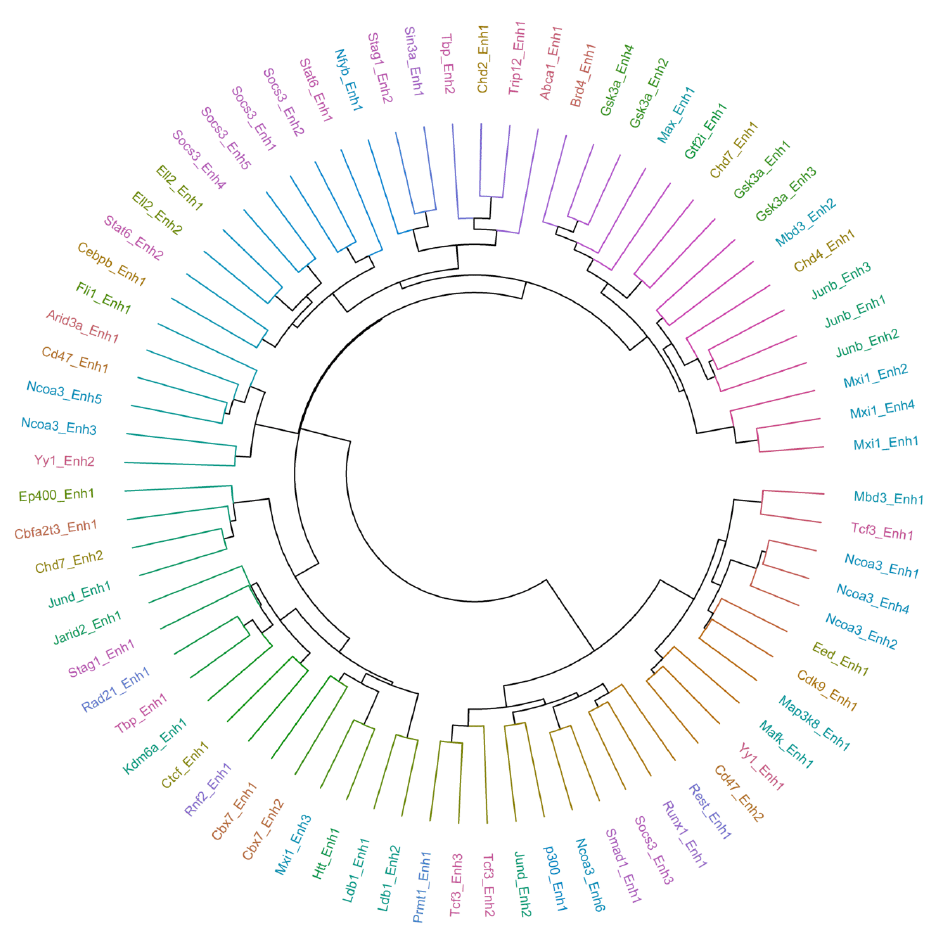
Figure 5. Hierarchical representation of similarities between transcription factor-target sets predicted using Findr-A causal inference on the FANTOM5 human